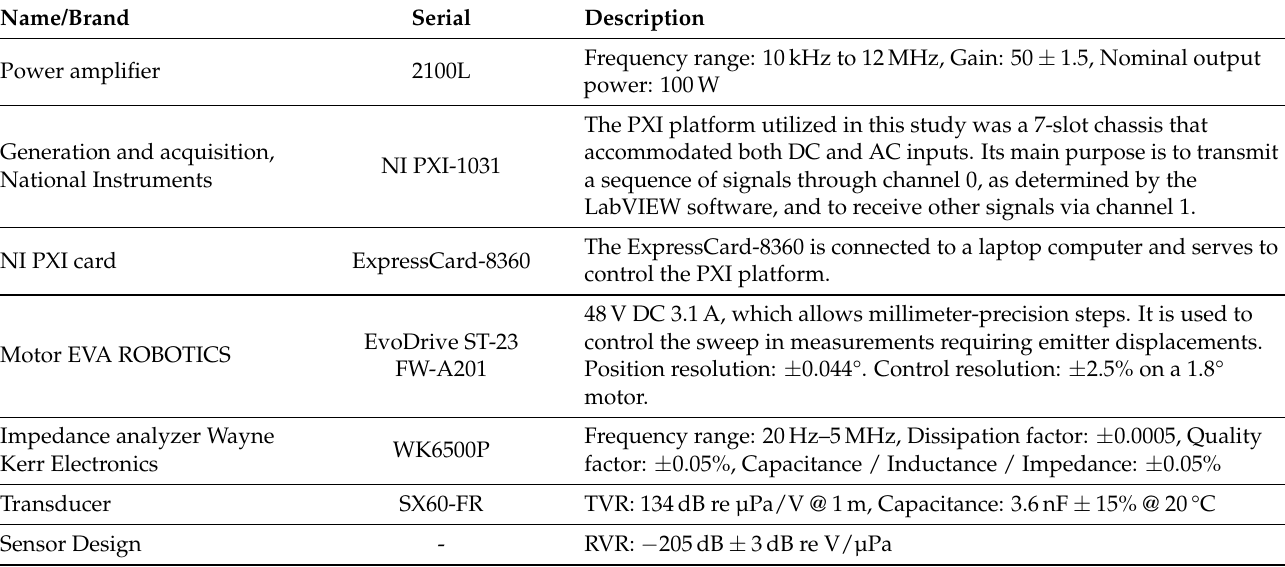
Table A1. Devices employed for the characterization of